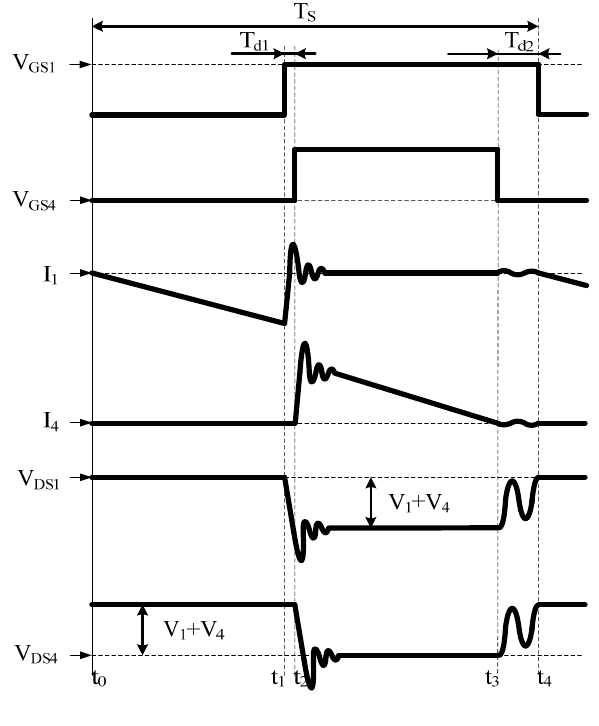
Figure 4. Key waveforms of the proposed bidirectional flyback converter balancing